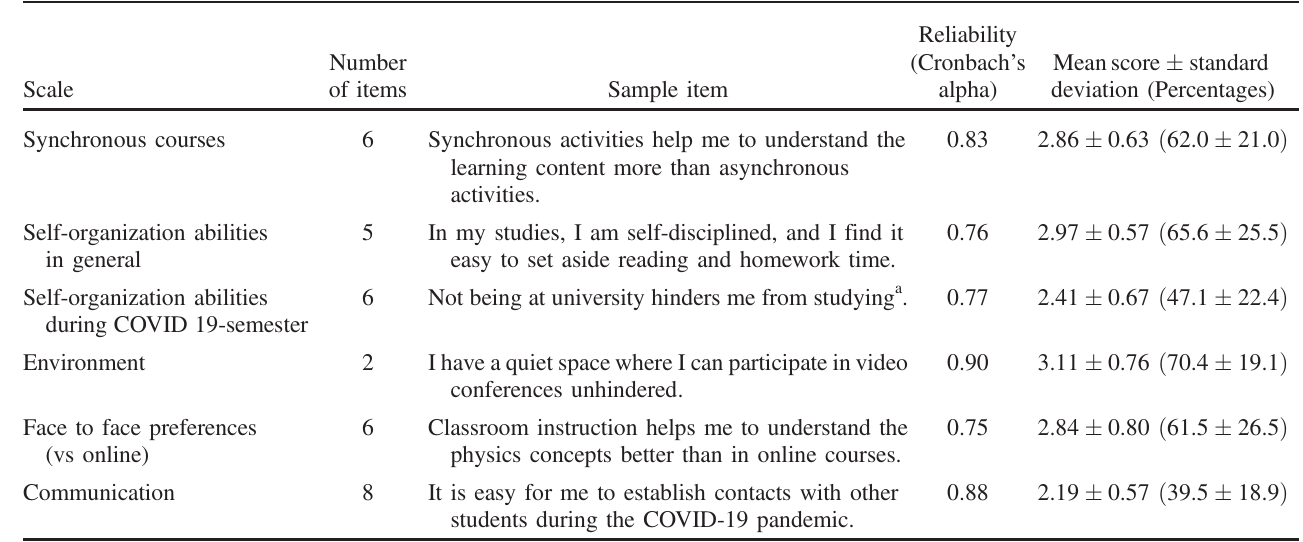
TABLE IV. Description and psychometric characteristics of the scales that were used for all students. The mean scores obtained from the rating scales were linearly transformed to a percentage scale where 0 means lowest and 100 means highest expression. The percentages are provided in